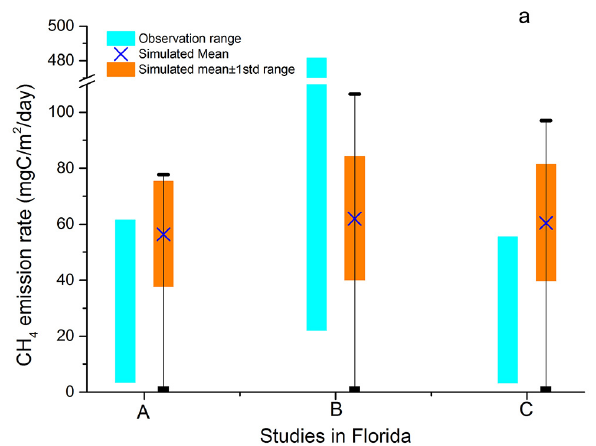
Figure 5a. Comparisons between simulation results of mean (cross symbol) ± 1SD (orange column) and maximum and minimum (short bar) emission rates and observed emissions range (light blue column) of studies A: Bartlett et al. (1989), B: Burke Jr.